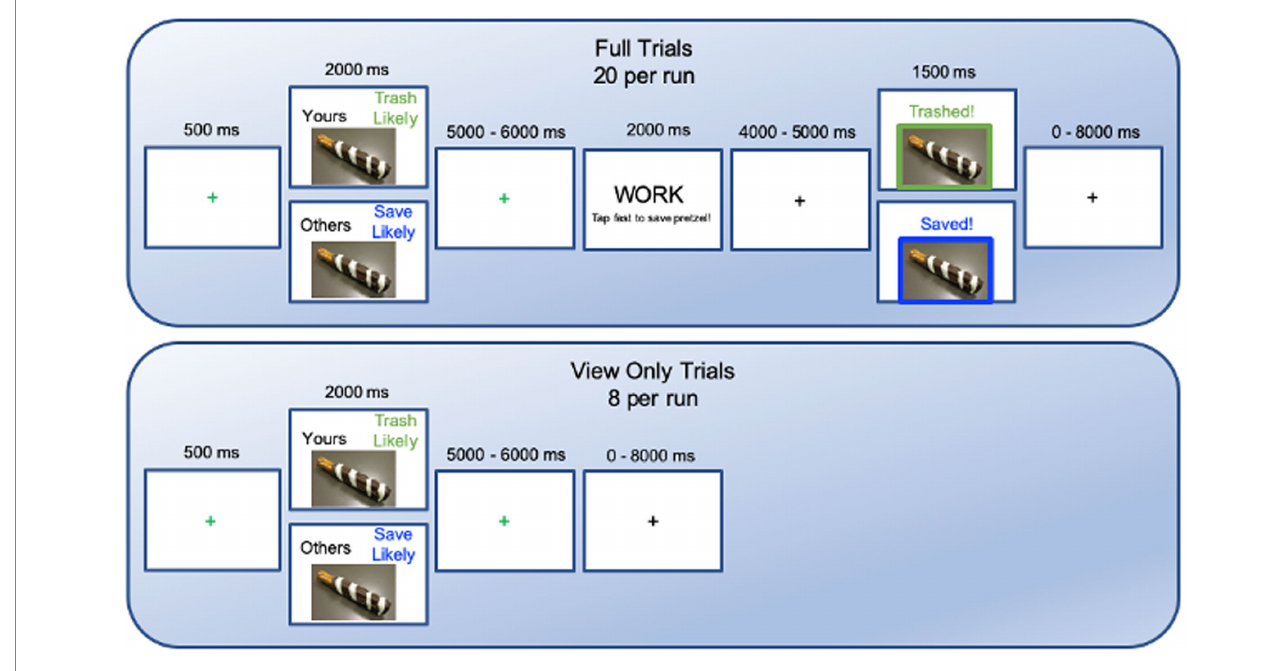
FIGURE 1 Sequence of events in the fMRI Pretzel decorating